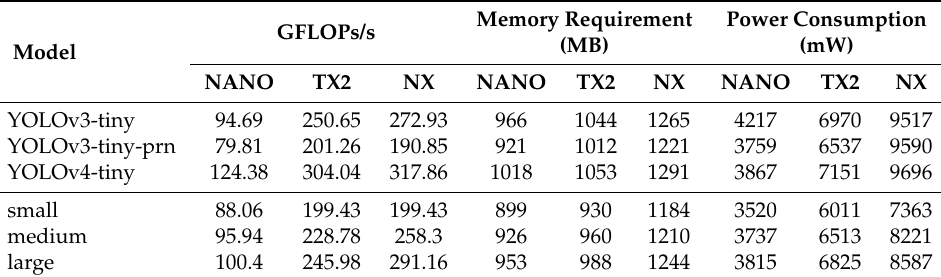
Table 4. Comparison of GPU profile information.